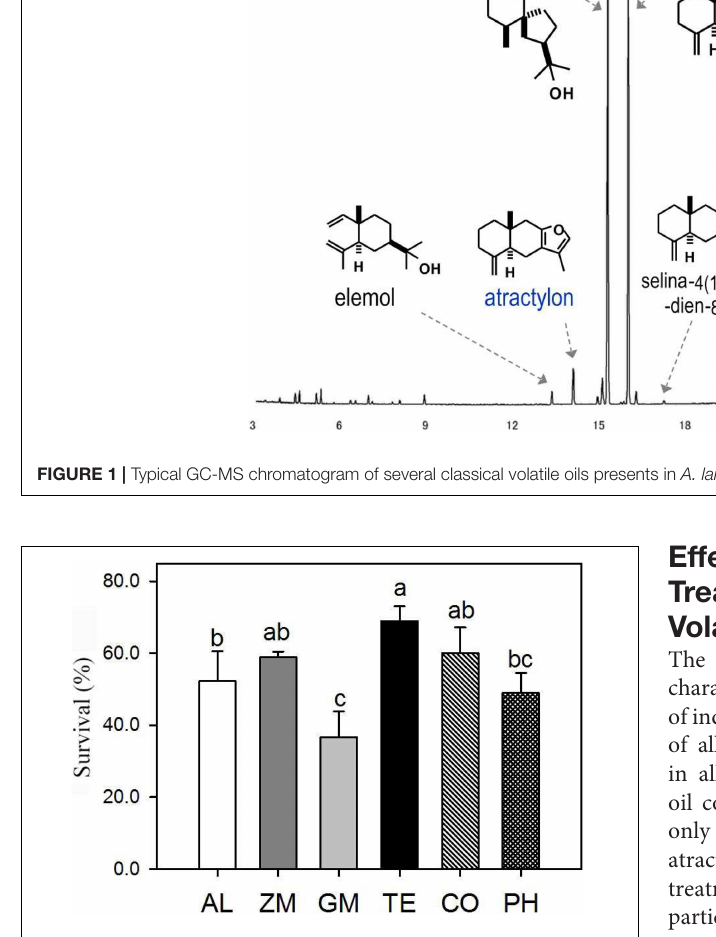
FIGURE 2 | Effect of different intercropping treatments on the percentage survival of A. lancea in 2016. Different lowercase letters indicate significant differences at the 5% significance